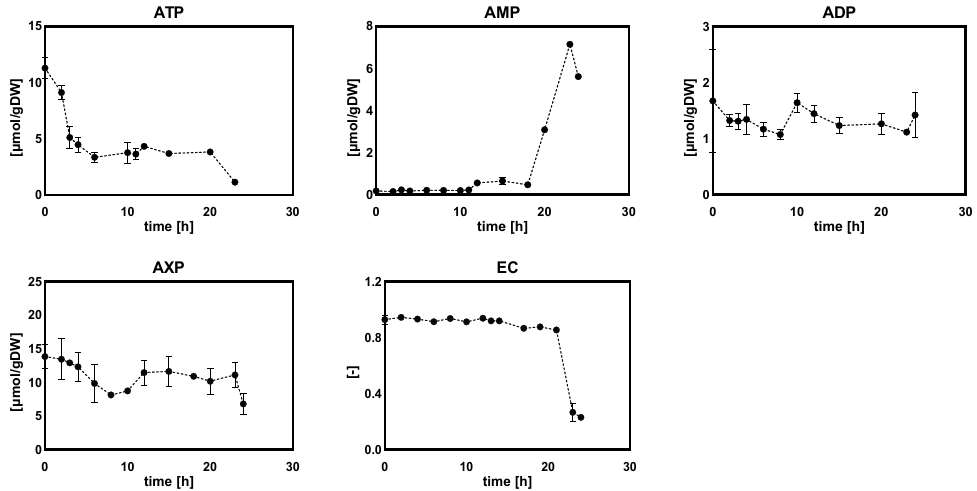
Figure 14. Intracellular amounts of adenine nucleotides and energy charge in Penicillium chrysogenum Wisconsin 54-1255 under DO ramp-down experiments. The dissolved oxygen was linearly decreased from 60% to 0% in 24 h. Time 0 represents the start of DO ramp-down.